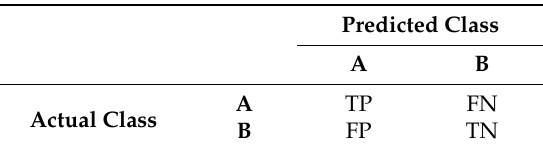
Table 4. Confusion matrix in classifying class